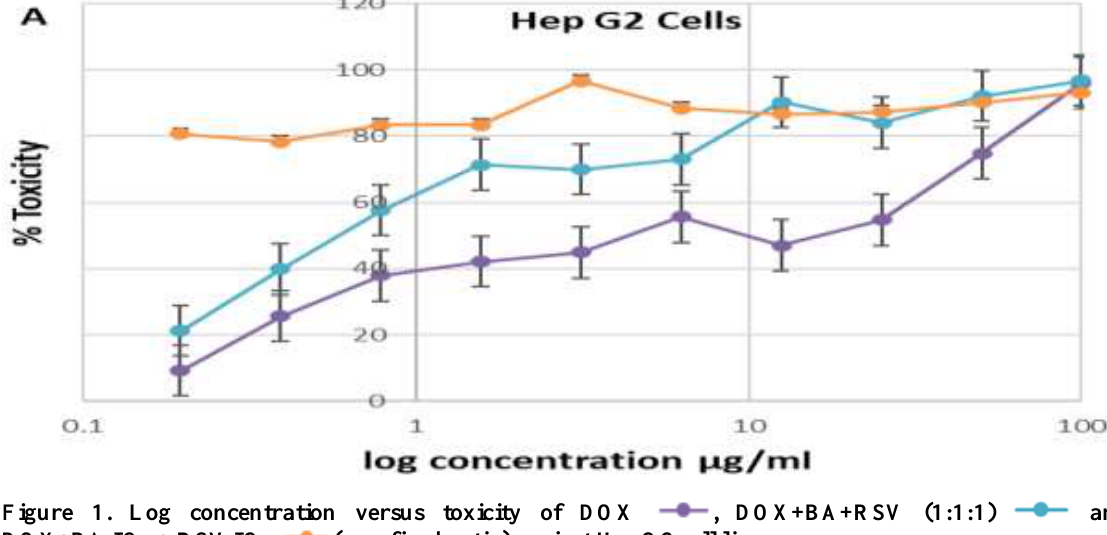
Figure 1. Log concentration versus toxicity of DOX , DOX+BA+RSV (1:1:1) and DOX+BA.IC 50 + RSV.IC 50 (non-fixed ratio) against HepG2 cell line.